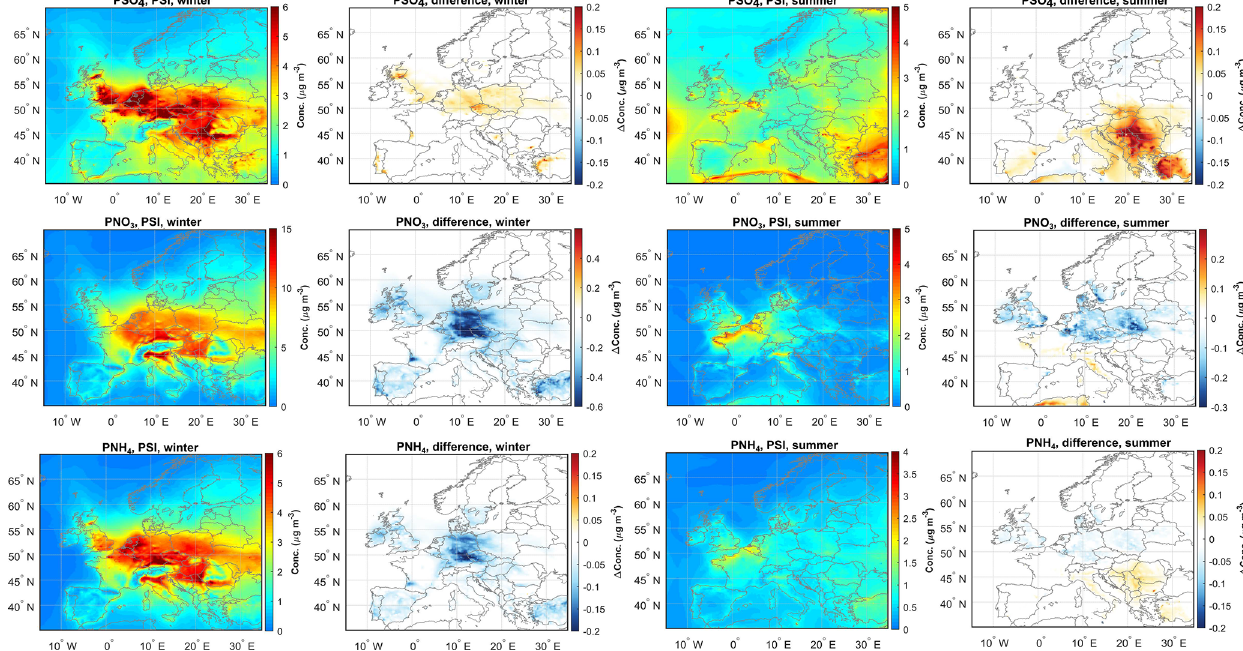
Figure 10. Modelled secondary inorganic aerosol (SIA) concentrations using PSI emissions and the difference between PSI and